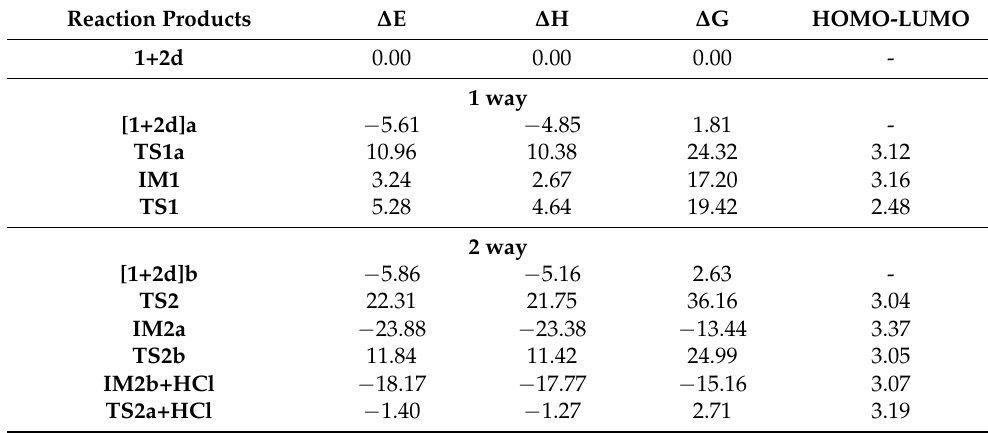
Figure 2. The structures of 3d ( a ) 5d ( b ). Table 2. Relative energies ( ∆ E, kcal/mol), enthalpies ( ∆ H, kcal/mol), Gibbs free energies ( ∆ G, kcal/mol) and HOMO-LUMO gaps (eV) for reagents ( 1+2d ), pre-reaction complexes [1+2d], transition states TS, intermediates IM and products 3d and 5d of the reaction of 4,6-dichloro-5- nitrobenzofuroxan 1 with 2-morpholinoethanamine 2d . Reaction